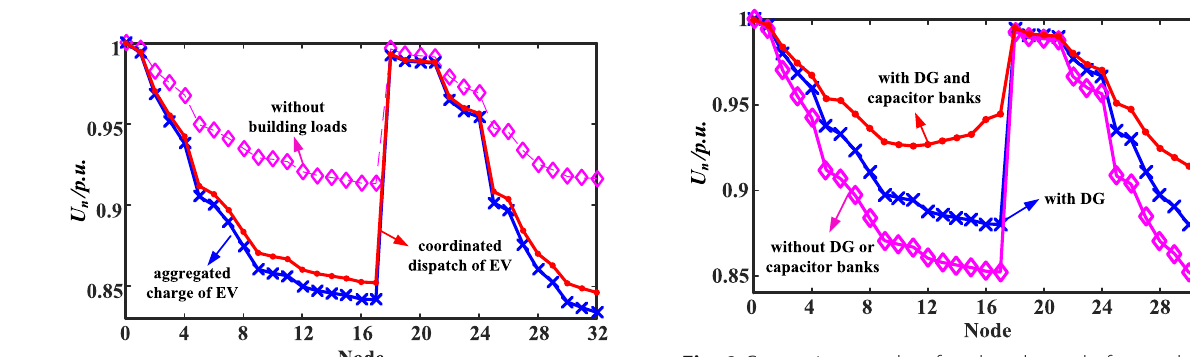
Fig. 9 Comparison results of node voltages before and after reactive compensation